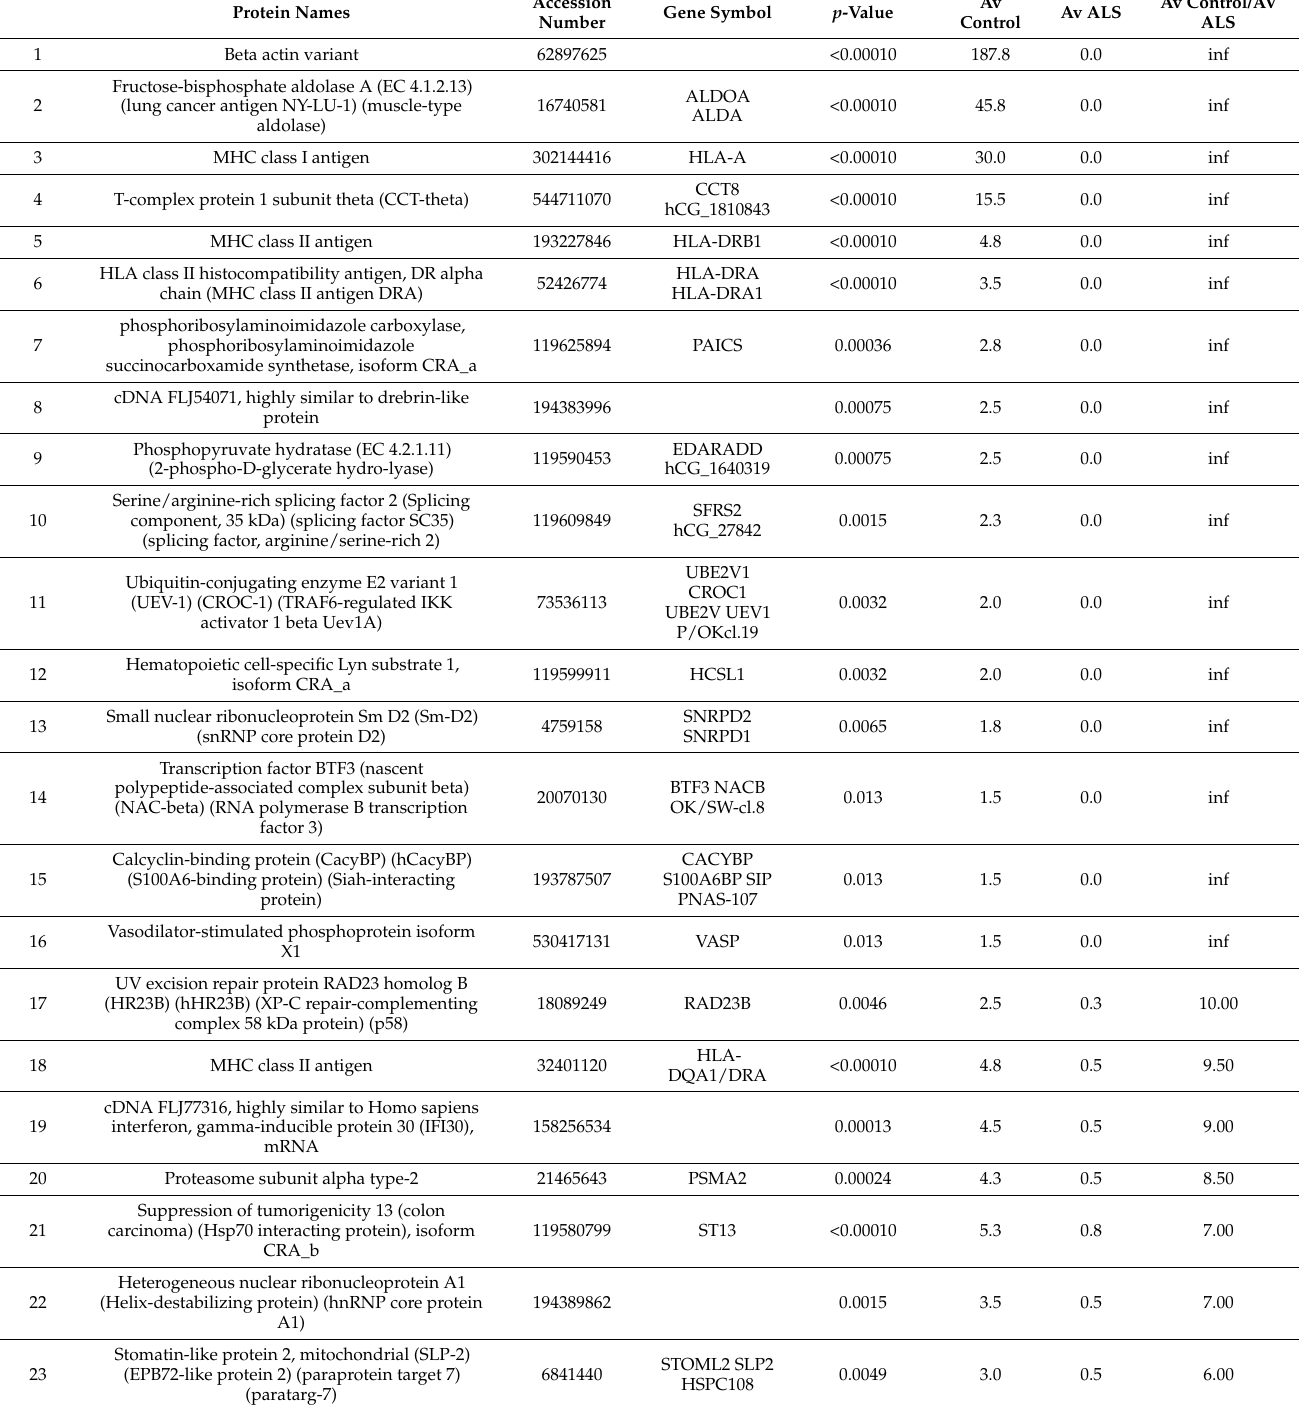
Table 1. Dysregulated proteins identified in our